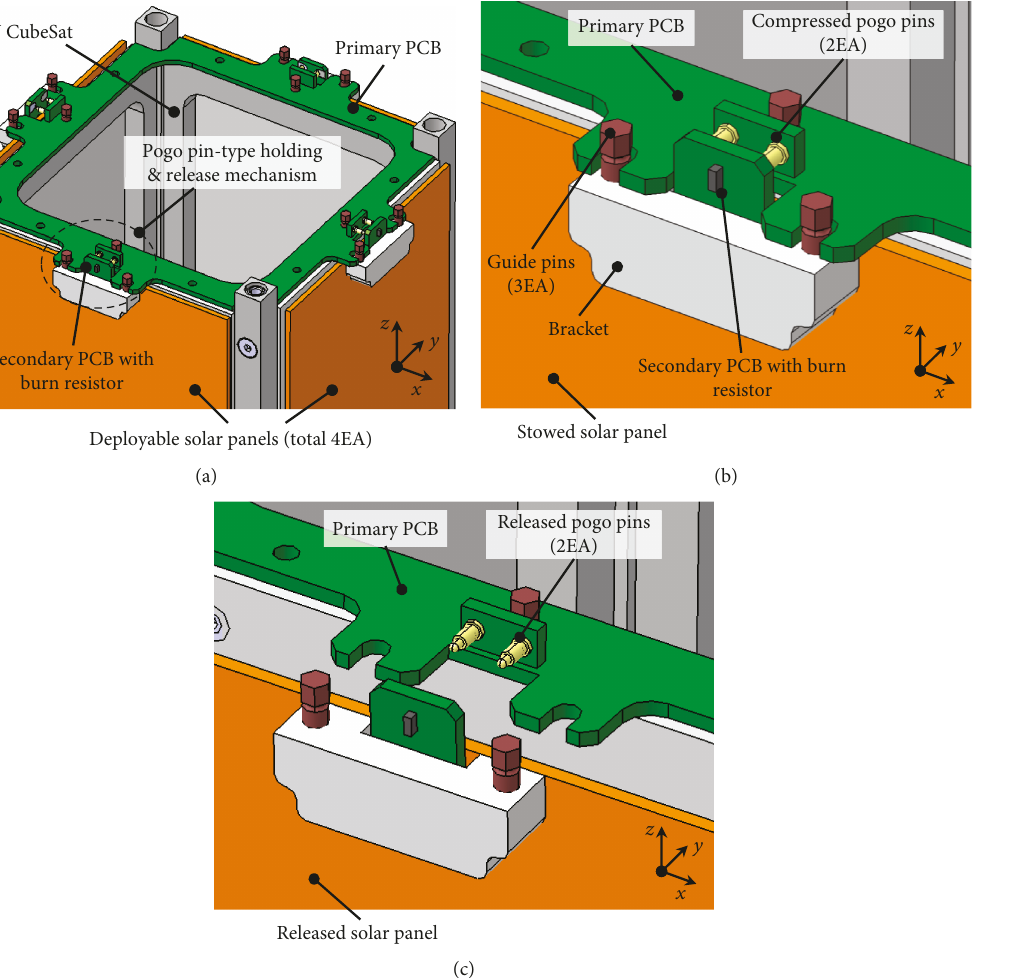
Figure 3: Con fi guration of a pogo pin-type holding and release mechanism proposed in the study: (a) overall con fi guration, (b) holding state, and (c) release